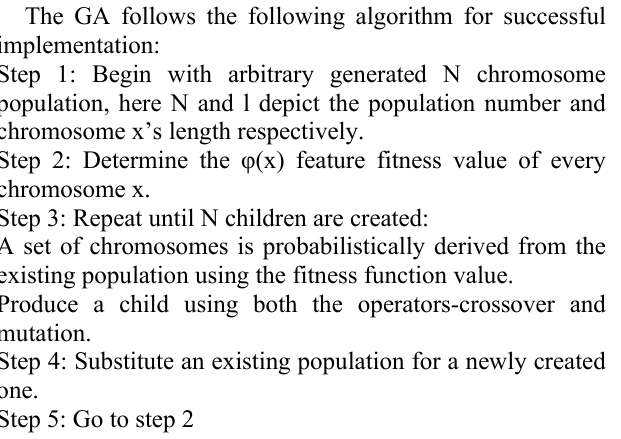
Figure 6. Structure of Genetic